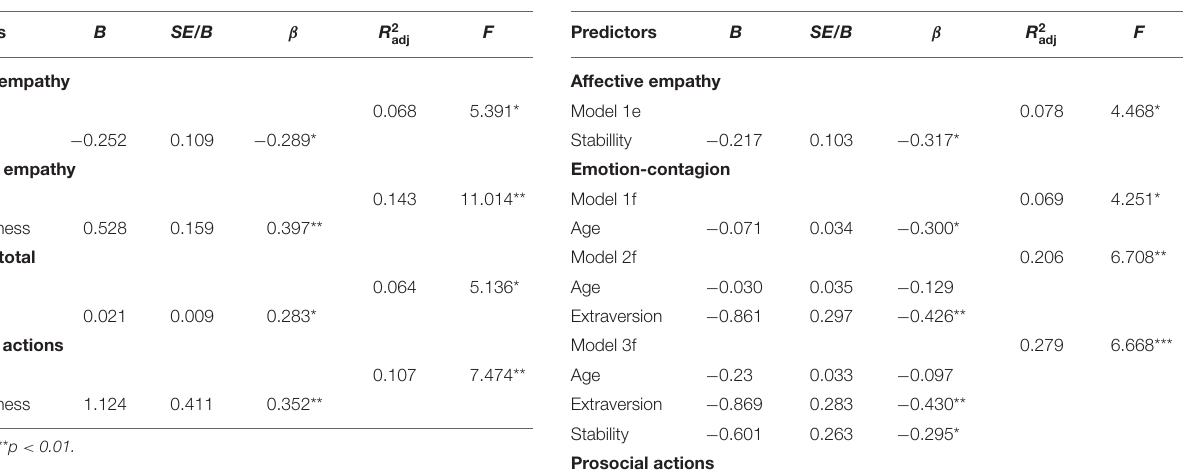
TABLE 5 | Predictors of children’s empathy skills as perceived by fathers according to children’s individual